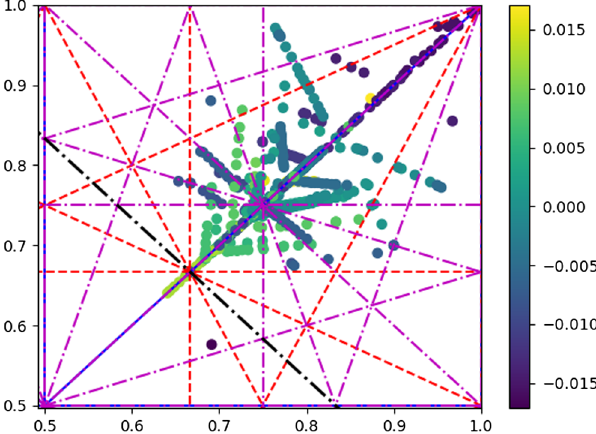
14. Tune diagram for horizontal, vertical, and longitudinal degrees of freedom, color coded by momentum